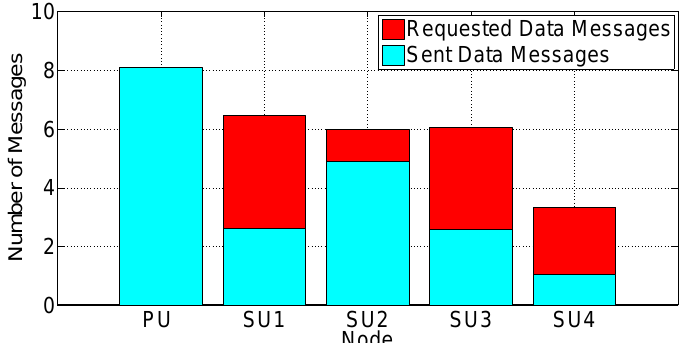
Figure 24. Number of requested DATA messages and number of replica DATA messages sent upon the reception of a request, in Scenario